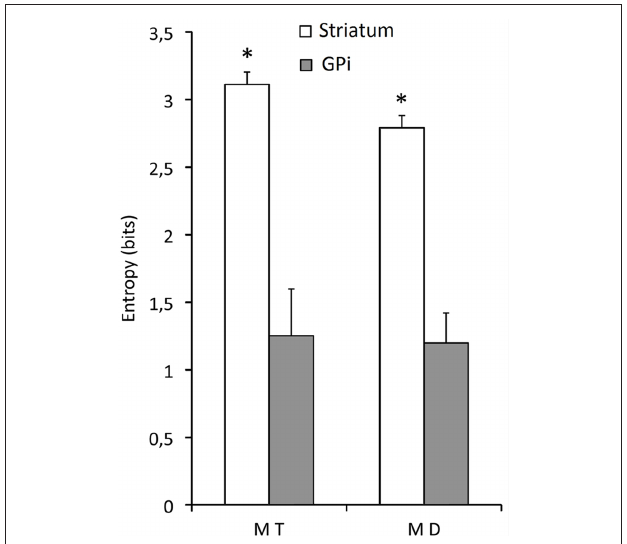
Figure 4 | NieTH entropies computed for neurons in monkey T and monkey D. Error bars indicate SEM (Student’s t -test, p <